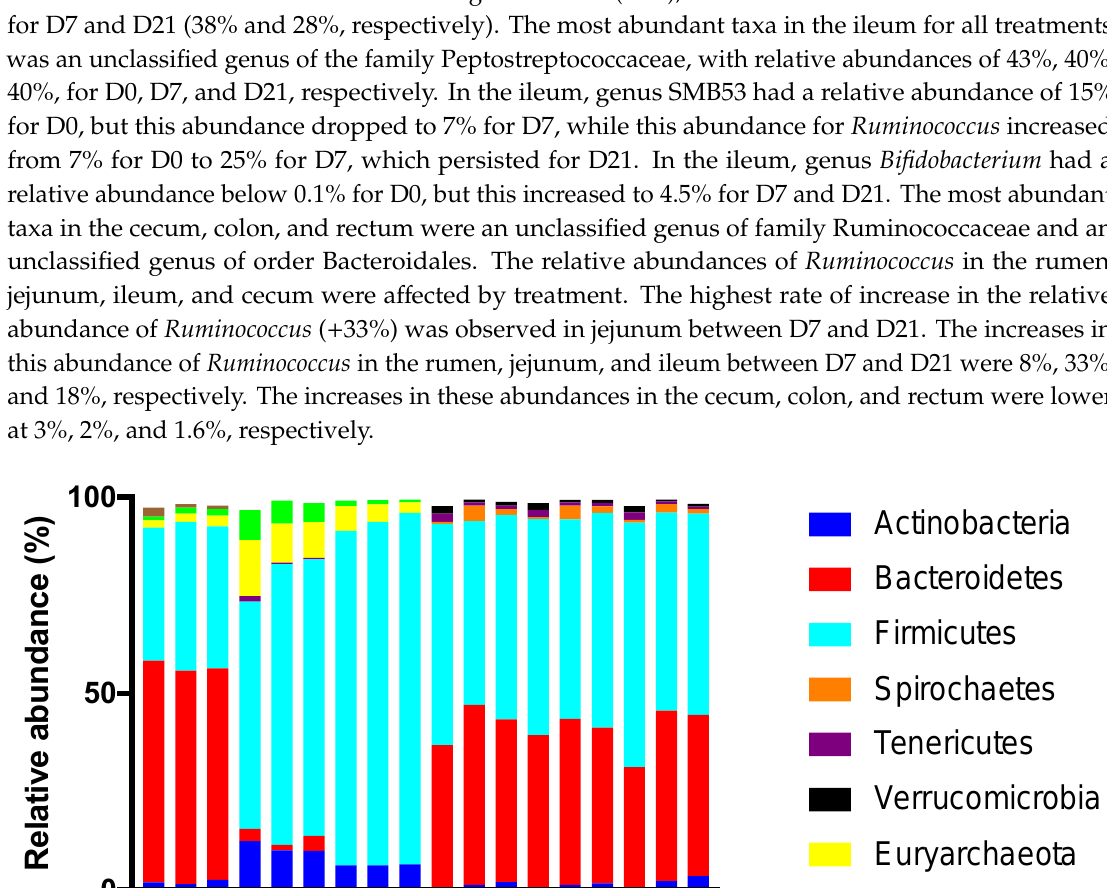
Figure 6. Relative abundances of abundant genera by treatment (0 = no grain feeding, 7 = moderate grain feeding for 7 d, 21 = moderate grain feeding for 21 d) and region of the digestive tract.